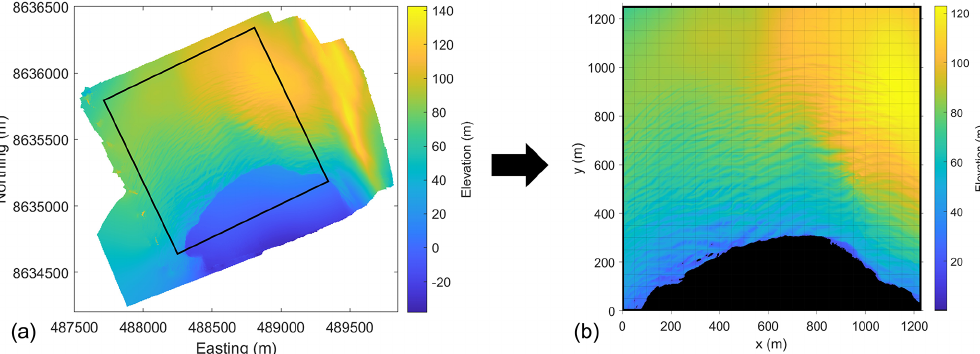
Figure 2. The originally mapped DEM (a) of Fridtjovbreen was rotated and cropped (black frame) before being used for the model calcula- tions. Additionally, the elevation values of the sea ice area were removed, and the whole DEM was divided into sub-grids of 50m × 50m (b)